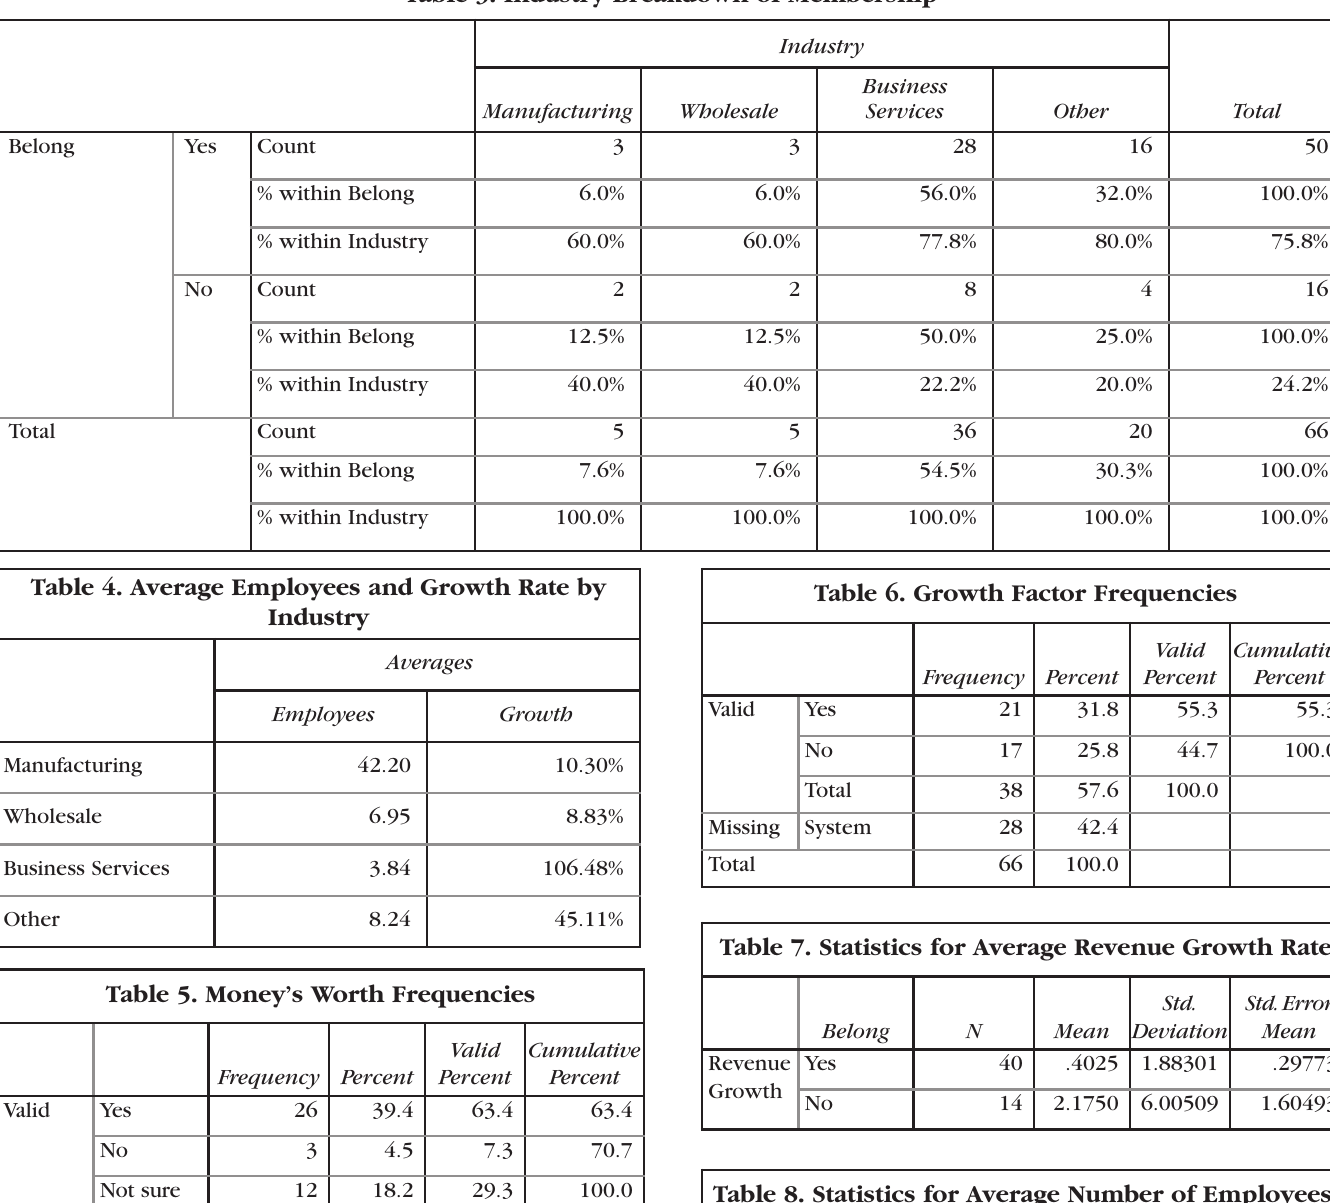
Table 3. Industry Breakdown of Membership